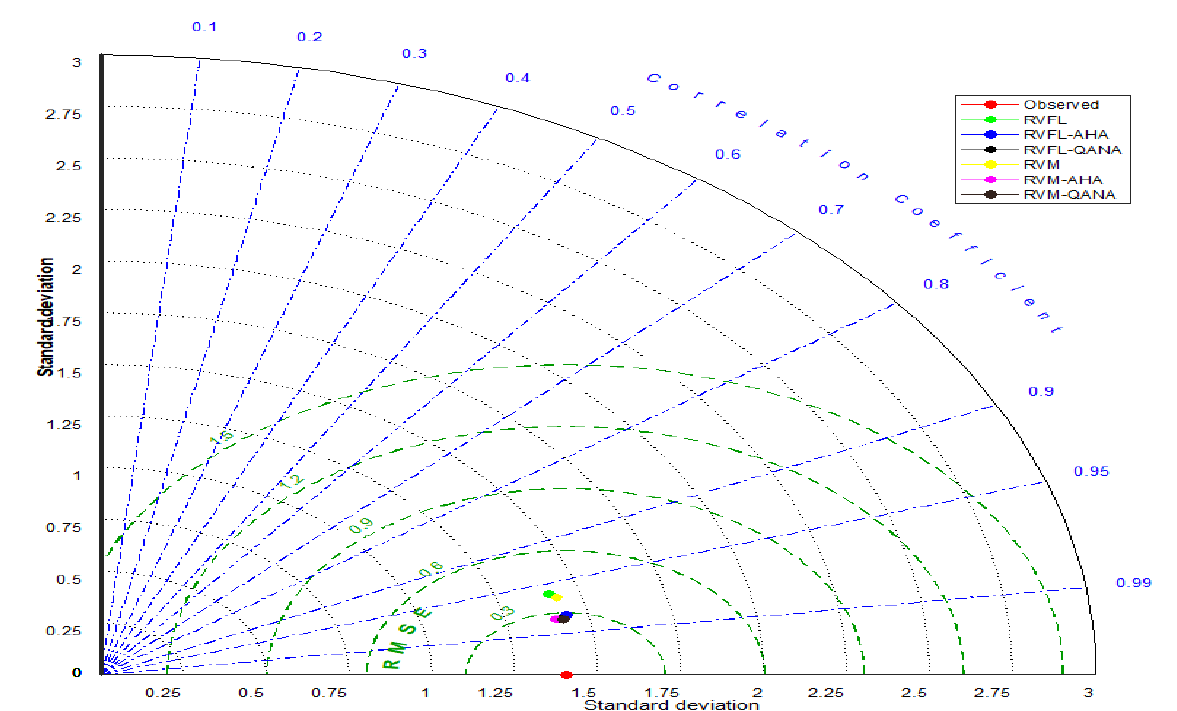
Figure 7. Taylor diagrams the predicted ET by different RVFL‑ and RVM‑based models in the test period using the best input combination –Station 1 (Faisalabad).